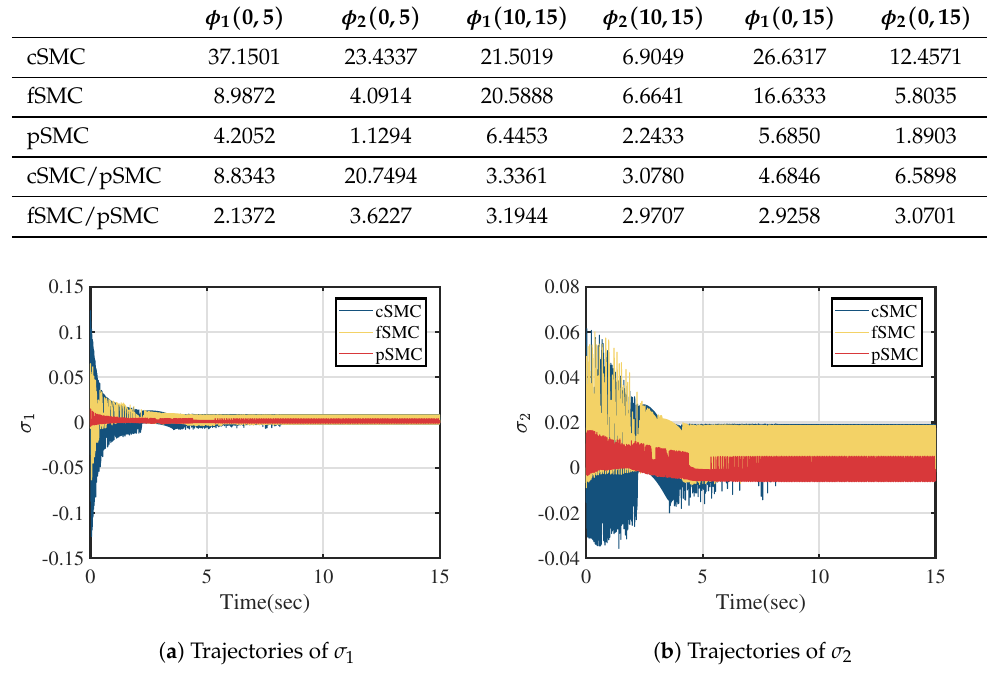
Figure 4. The trajectories of sliding variables σ 1 and σ 2 when ρ b = 0.9: cSMC (Blue solid line), fSMC (Yellow solid line) and pSMC (Red solid